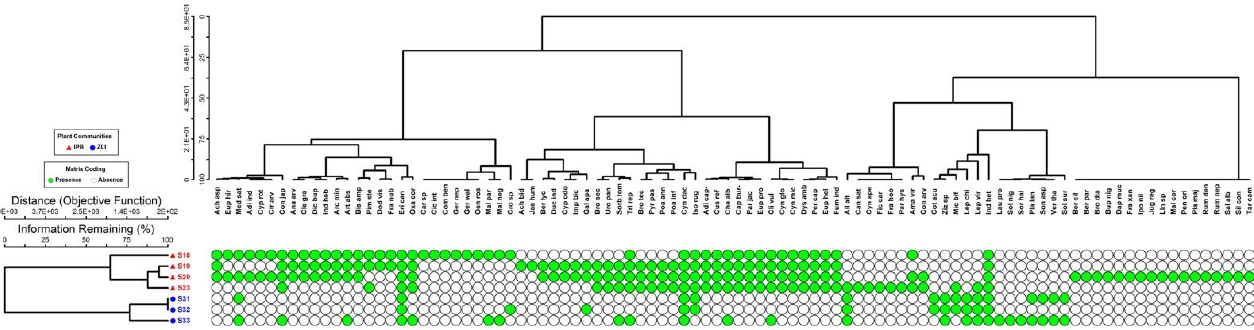
Figure 4. TWCA analysis indicating two different groups recognition based up on 97 plant species recorded from seven sampling sites. Each green dot shows the presence, and a white dot indicates the absence of a species within each stand or sampling site. IPB: Indigofera-Parrotiopsis-Bistorta and ZLQ: Ziziphus-Letopus-Quercus.